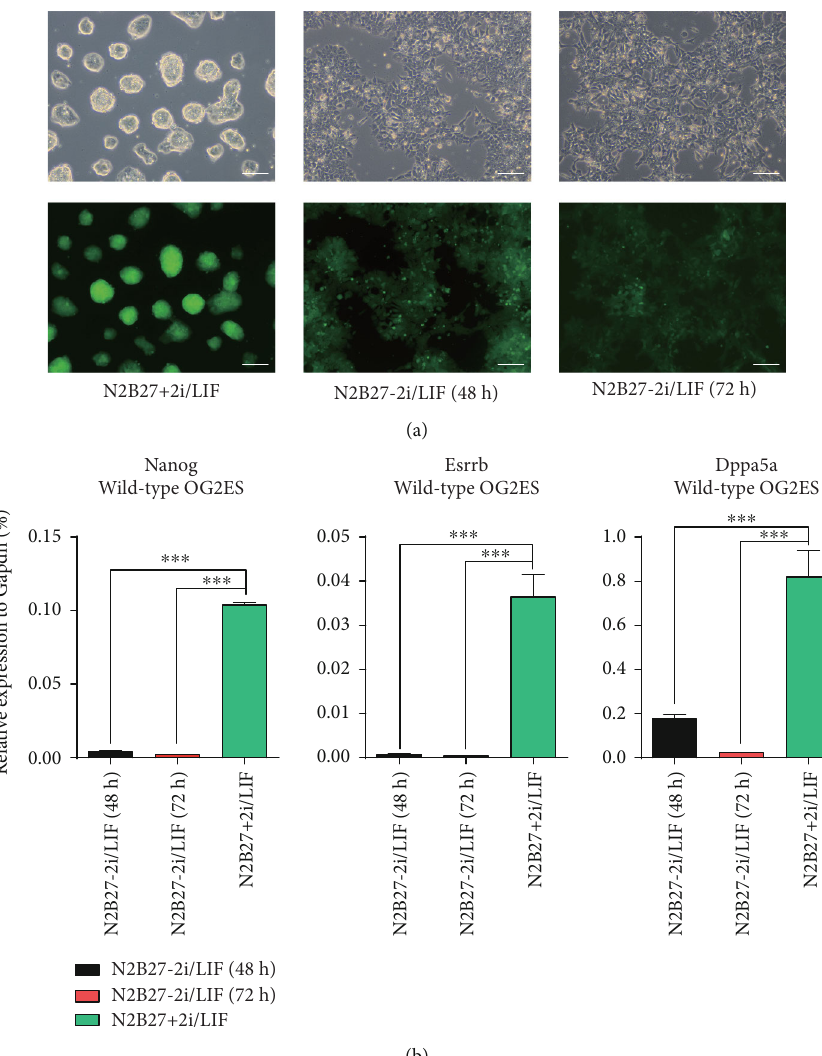
Figure 2: OG2 mESCs treated by withdrawing 2i/LIF. (a) All groups were cultured in N2B27+2i/LIF for the fi rst 24 hours, and then di ff erentiation was enabled by inhibitor removal for another 48 or 72 hours in the experimental groups, while the control group was cultured in N2B27+2i/LIF for additional 48 hours. Scale bar, 100 μ m. (b) RT-qPCR analysis of the expression of three pluripotency factors in wild type. OG2 mESCs treated by withdrawing 2i/LIF. The error bar represents standard error, ∗∗∗ P < 0 : 001 vs. the control group, n = 2